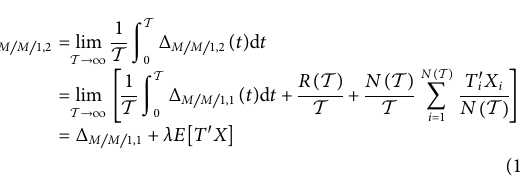
FIGURE 9 Age computation at (M/M/1) queue n based on age at queue n −